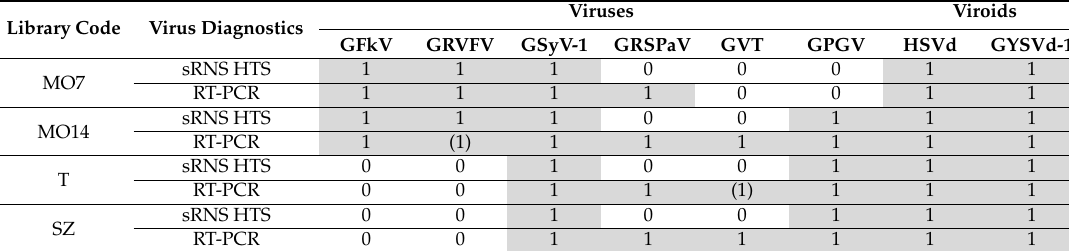
Table 2. Results of the virus diagnostics of the mother plants.